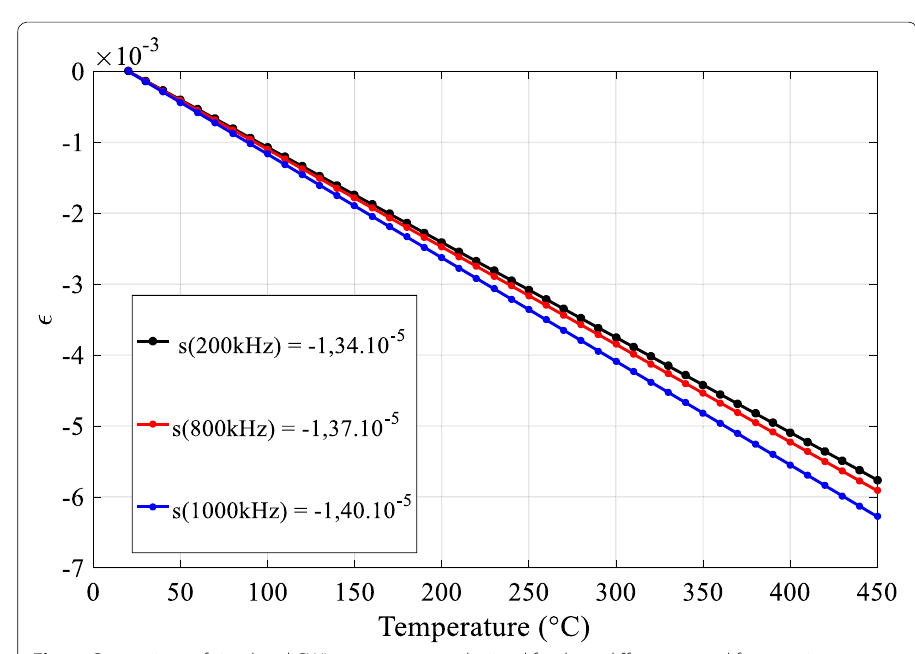
Fig. 5 Comparison of simulated CWI measurements obtained for three different central frequencies ( f 0 200 kHz, f 0 800 kHz and f 0 1000 kHz) of the Ricker-shaped source, for which the condition necessary = = = to assume a strong scattering regime is verified. Relative time delays are measured by the “ stretching technique ” when comparing the waveform recorded at a given temperature with respect to the reference waveform. A linear regression is fitted to the measurements to estimate the slopes s ( f 0